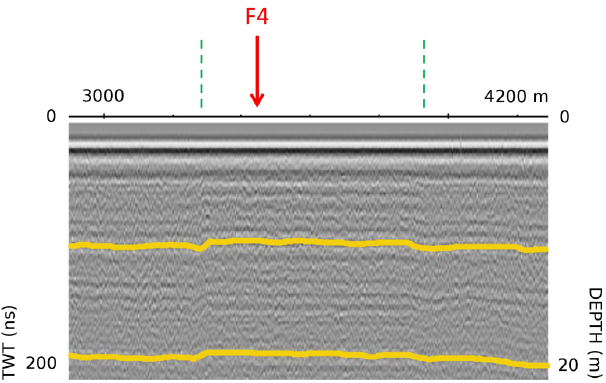
Fig. 4. Transition between the “real” and “natural” snow surface visible on radargram 9 in the vicinity of core F4. The first dotted line corresponds to the point where the radar vehicle left the transect route and the second one to the point where it got back on the